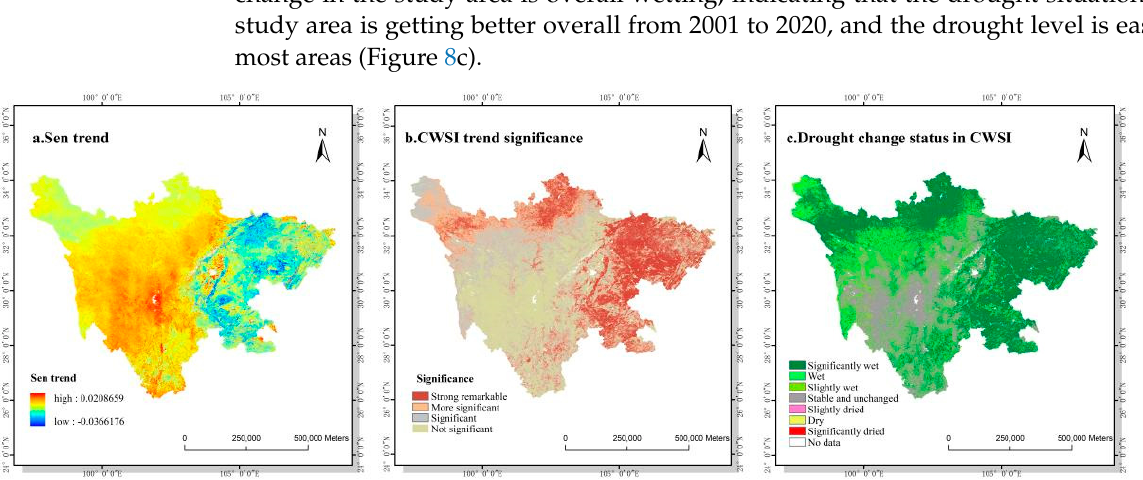
Figure 7. Trend of drought based on CWSI in Sichuan Province from 2001 to 2020.